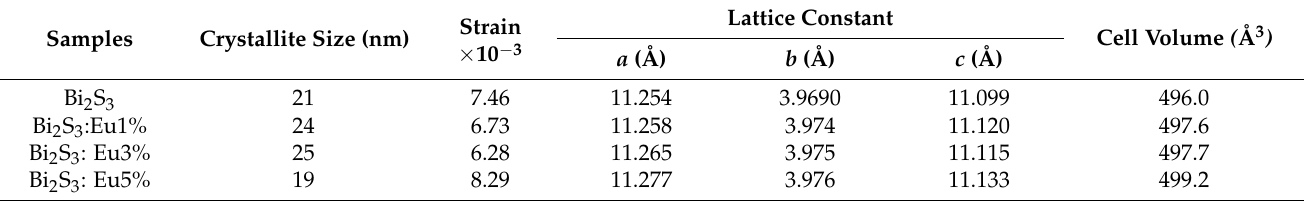
Table 1. Crystallite size, strain, lattice constants, and cell volume of the Eu doped Bi 2 S 3 thin films.